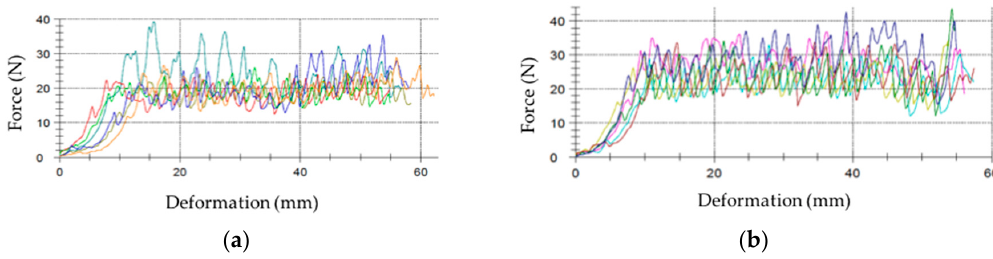
Figure 17. Developed peeling testing for interphase coating-laminate adhesion response quantification. ( a ) Developed specimens; ( b ) forces on testing; and ( c ) peeling testing system. Materials 2017 , 10 , 1146